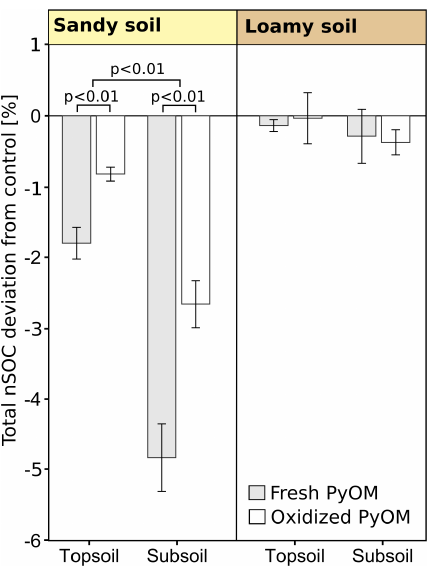
Figure 5. Relative deviations of native soil organic carbon (nSOC) to control of the total soils in soil columns (over all depth) after the percolation for sandy and loamy topsoil and subsoil with addi- tion of fresh and oxidized PyOM ( ± 1SE). Negative values indicate leaching losses. The significance of differences of fresh and oxi- dized PyOM and the significance of the deviation from the control are shown with p values. No significant differences were found for the loamy soil.